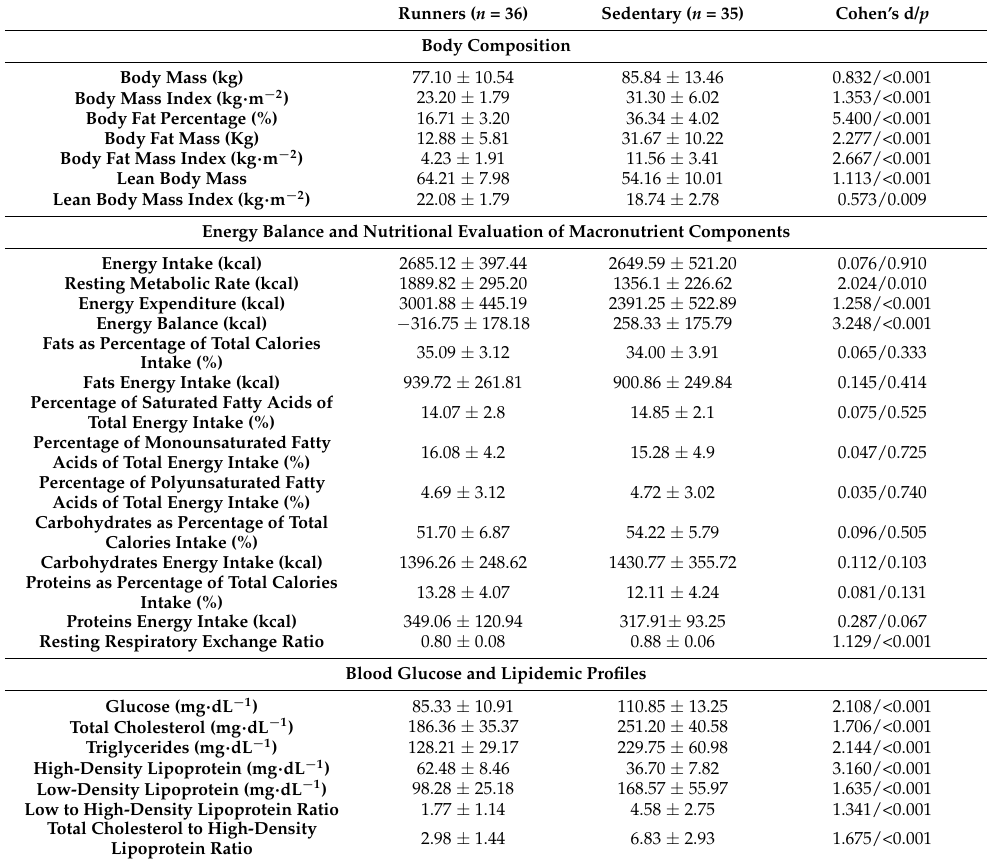
Table 1. Participants characteristics (All data are presented as means ±